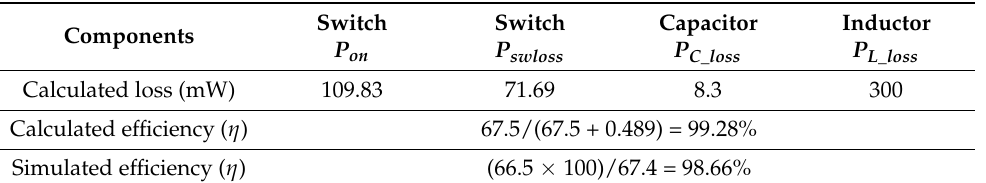
Table 6. Theoretical losses for the SCL -based proposed technique across each component when one PV module is half shaded.